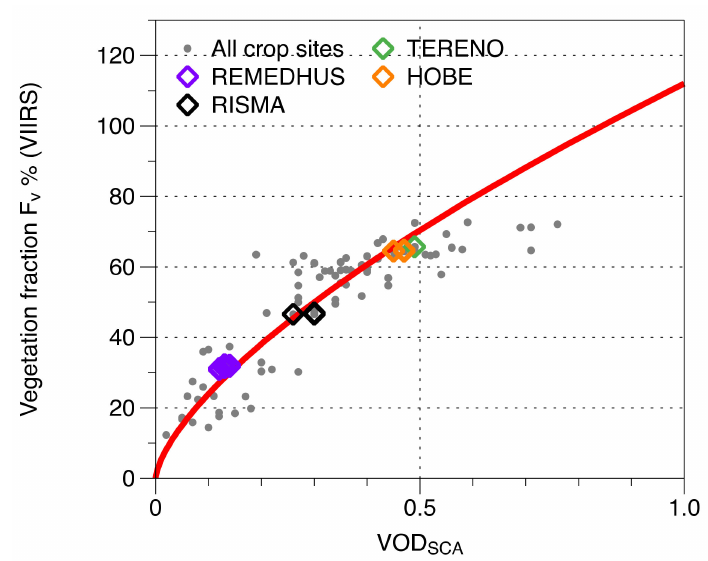
Figure 2. Scatter plot with vegetation optical depth single channel algorithm (VOD-SCA) and the measured vegetation fraction (VIIRS) over croplands (grapy points and colored diamond) and Green Vegetation Fraction ( GVF ) simulation with the VOD ranged from 0 to 1 by Equation (13) (red